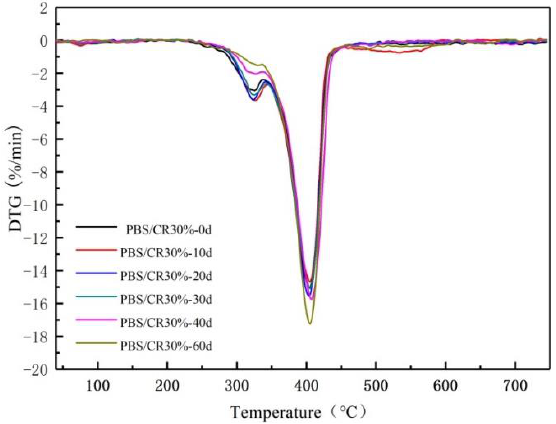
Figure 11. Derivative thermogravimetry (DTG) curves after disintegration of composites.